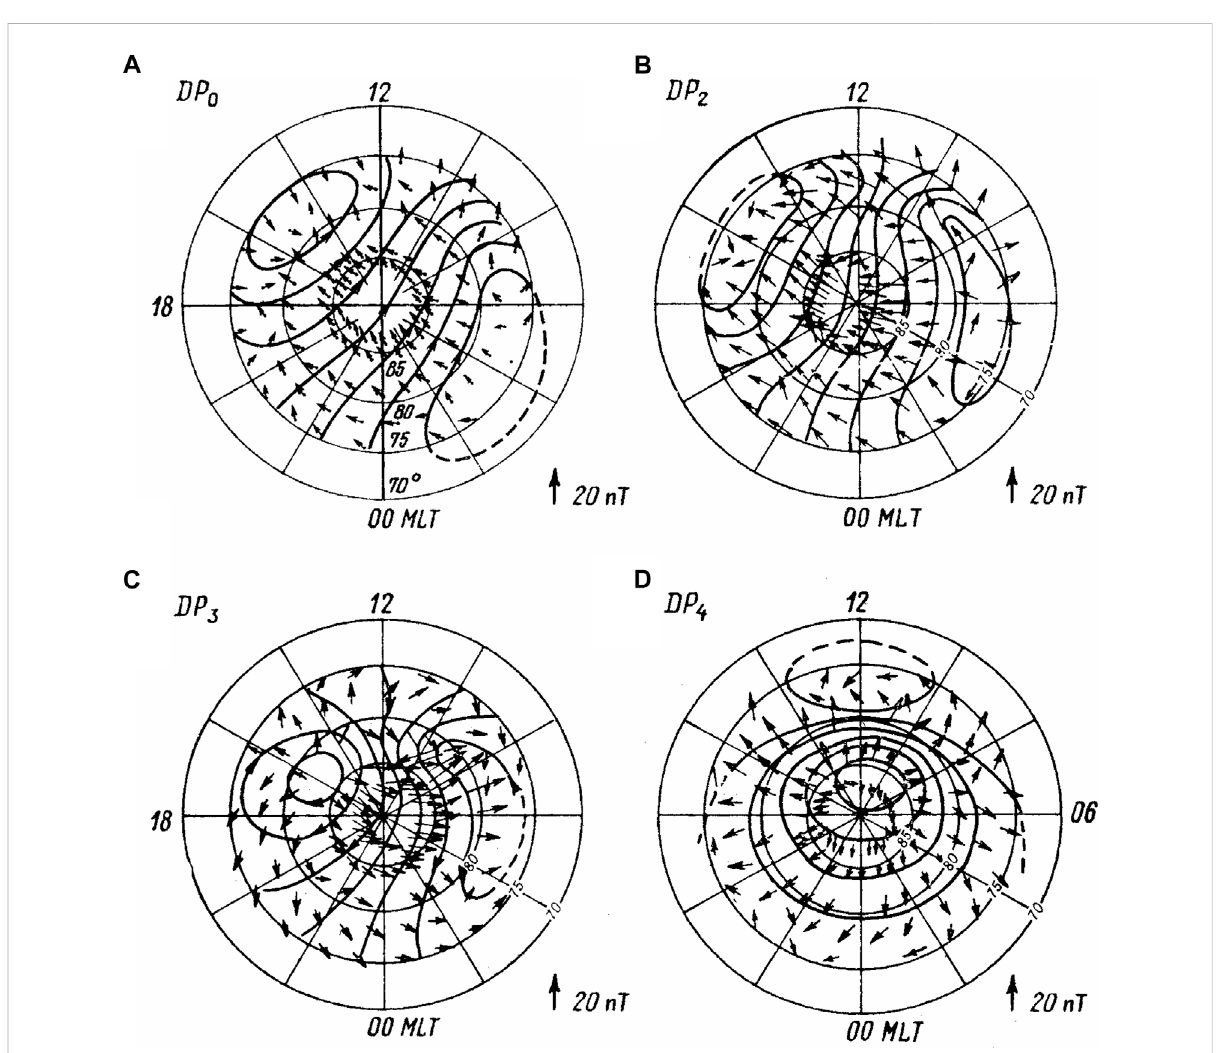
FIGURE 1 Currentsystemsofthepolarcapmagneticdisturbancesinsummerseason: (A) primarysystemDP0independentonIMF (B) DP2systemrelated tosouthwardB ZS , (C) DP3systemrelatedtonorthwardB ZN , (D) DP4systemrelatedtoazimuthalB Y .Shortarrowspresentdistributionofthemagnetic disturbances vectors on the ground surface. (Troshichev and Tsyganenko,